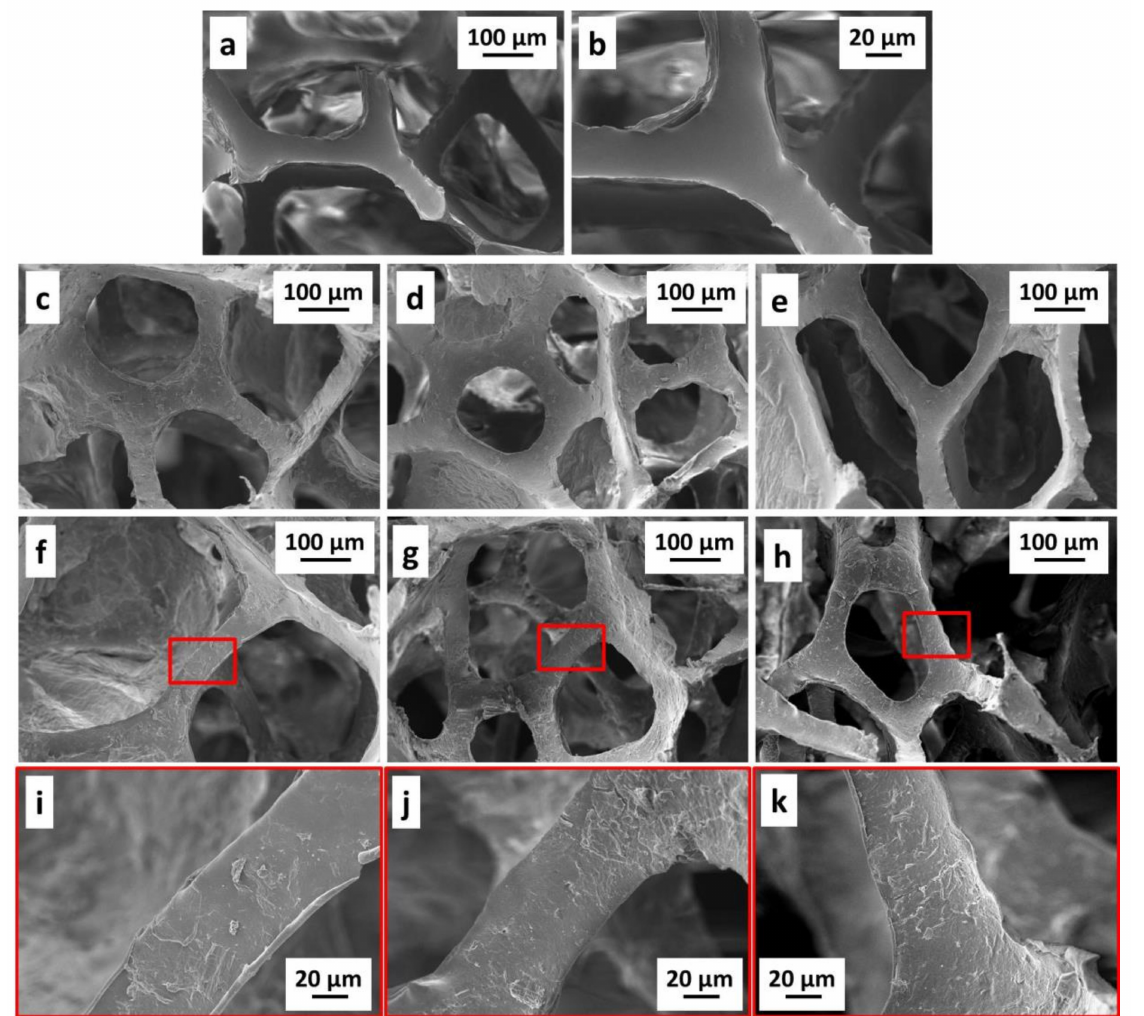
Figure 4. SEM micrograph of: ( a ) and ( b ) neat PU foam; 3BL ( c ) GO A , ( d ) GO B , ( e ) GO C ; 6BL ( f ) GO A , ( g ) GO B , ( h ) GO C ; high magnification micrograph of 6BL ( i ) GO A , ( j ) GO B , ( k ) GO C